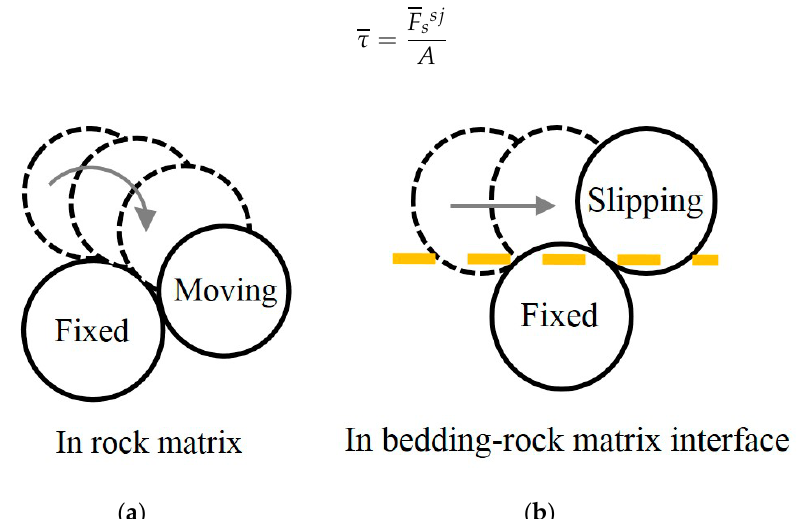
Figure 3. Different particle motions in rock matrix and bedding-rock matrix interface: ( a ) particle moves around one another in matrix; ( b ) particle slips along beddings (modified from Dou et al. [32]).